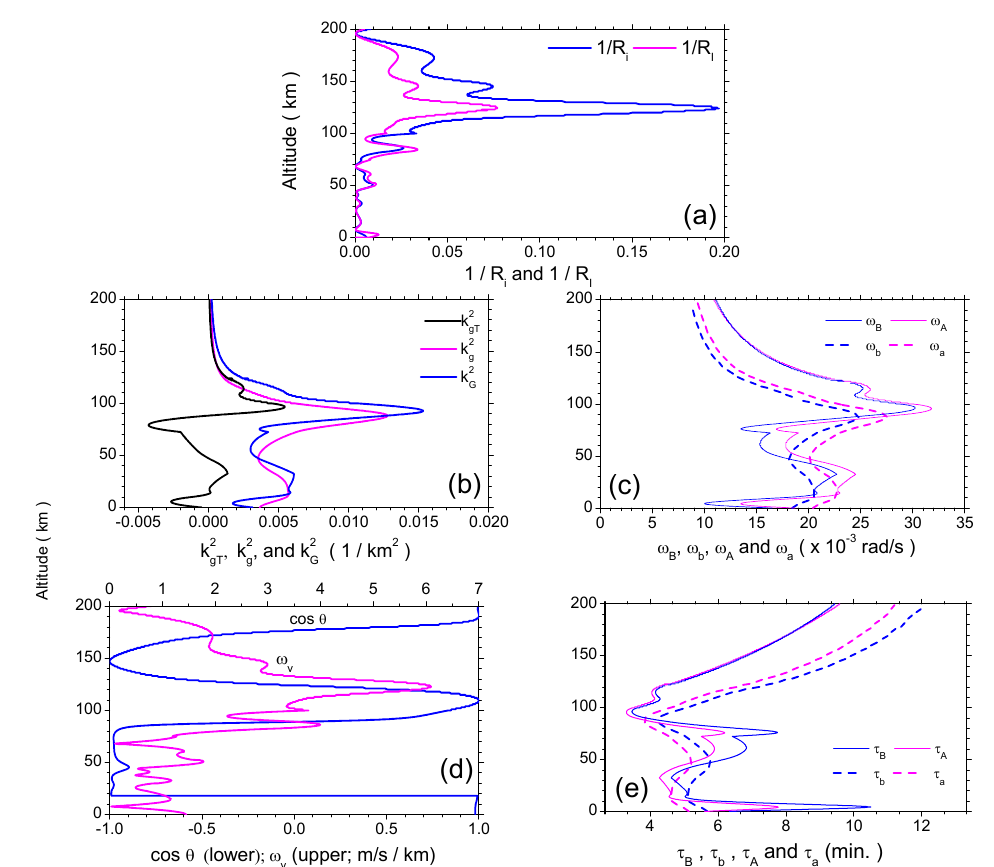
Figure 2. Vertical profiles of input parameters in Equation (11). ( a ) Richardson number R i (blue) and R I (pink); ( b ) k 2 (black), k 2 g (pink) and k 2 (blue); ( c ) buoyancy frequencies ω B (thin blue) and ω b gT G (dash blue) and cut-off frequencies ω A (thin pink) and ω a (dash pink); ( d ) cos θ (blue) and ω v (pink); ( e ) the four periods, τ B (thin blue), τ b (dash blue), τ A (thin pink) and τ a (dash pink), corresponding to the four frequencies in the upper right